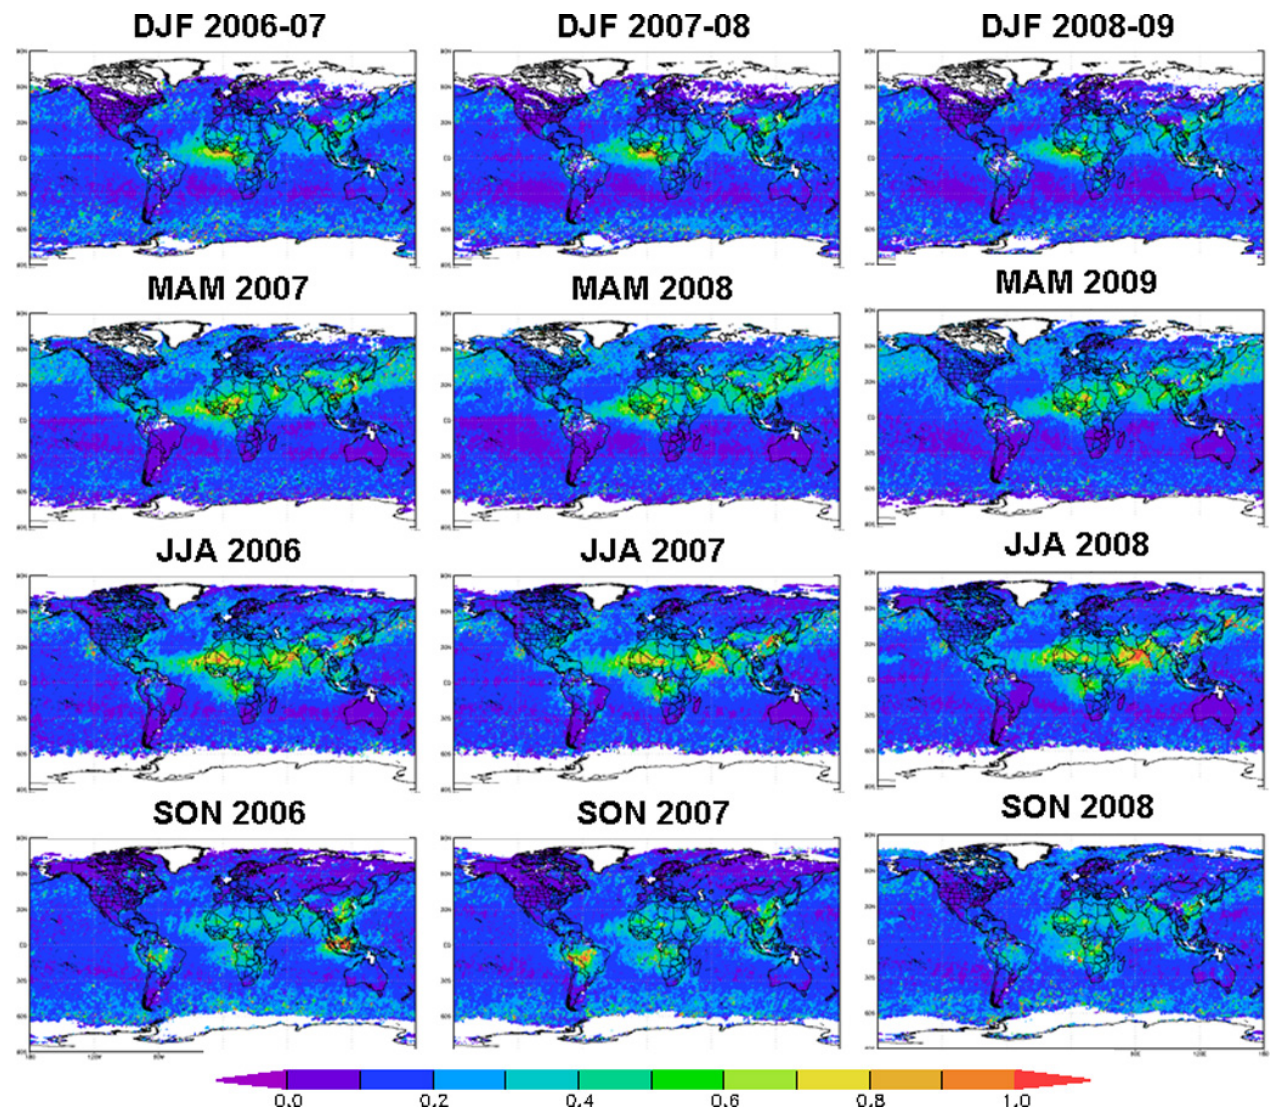
Fig. 2. Mean seasonal aerosol optical depths derived from the MISR